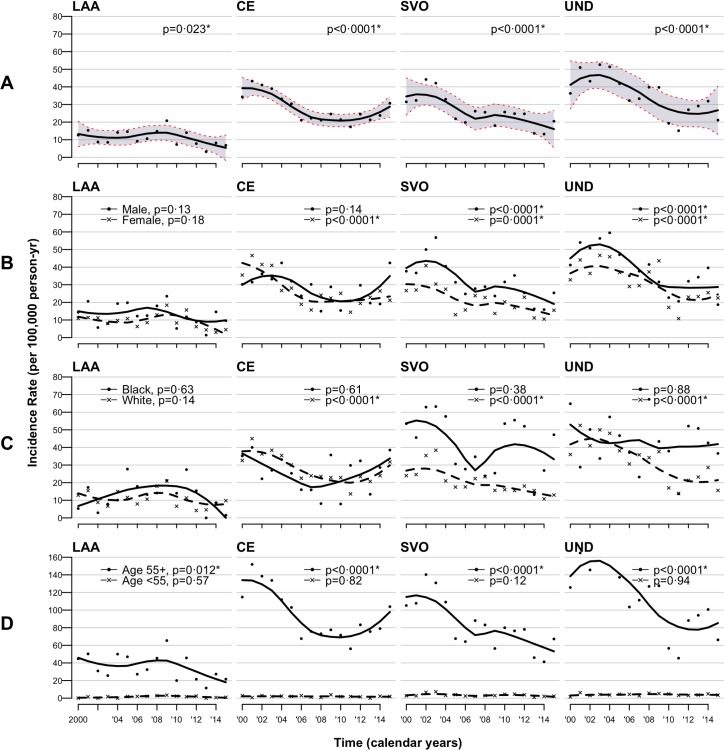
Trends in standardised† incidences per 100,000 per calendar year for IS aetiological subtypes; (A) overall, (B) by sex, (C) by ethnicity, and (D) by age groups. † To the 2011 census population of England and Wales. Data are the observed values with regression fitted lines (loess). p-Values were obtained from the Cochran-Armitage tests for trend. * denotes significant trends (p < 0.05). CE, cardio-embolism; IS, ischaemic stroke; LAA, large-artery atherosclerosis; loess, locally estimated scatterplot smoothers; SVO, small-vessel occlusion; UND, undetermined aetiologies.